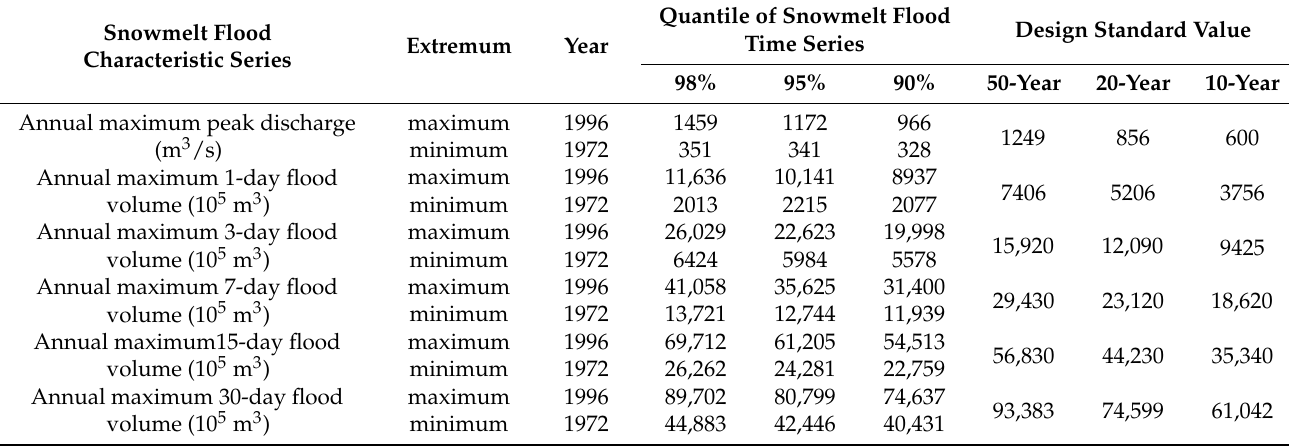
Table 9. Summary of the results of modeling the snowmelt flood time series with model 2 under non-stationary conditions. The results show estimates of the 90th, 95th and 98th percentiles. The design flood values for the 50-, 20-, and 10-year return periods of Kenswat Reservoir (approved by China Renewable Energy Engineering Institute in December